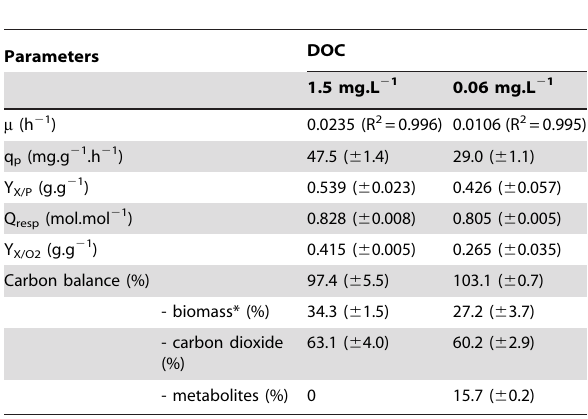
Table 2. Kinetic and respirometric rates and yields of phenol degradation by phenol-grown S. solfataricus 98/2 cells at two dissolved-oxygen concentrations